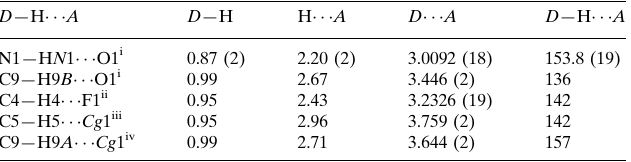
Hydrogen-bond geometry (A˚ , (cid:1)